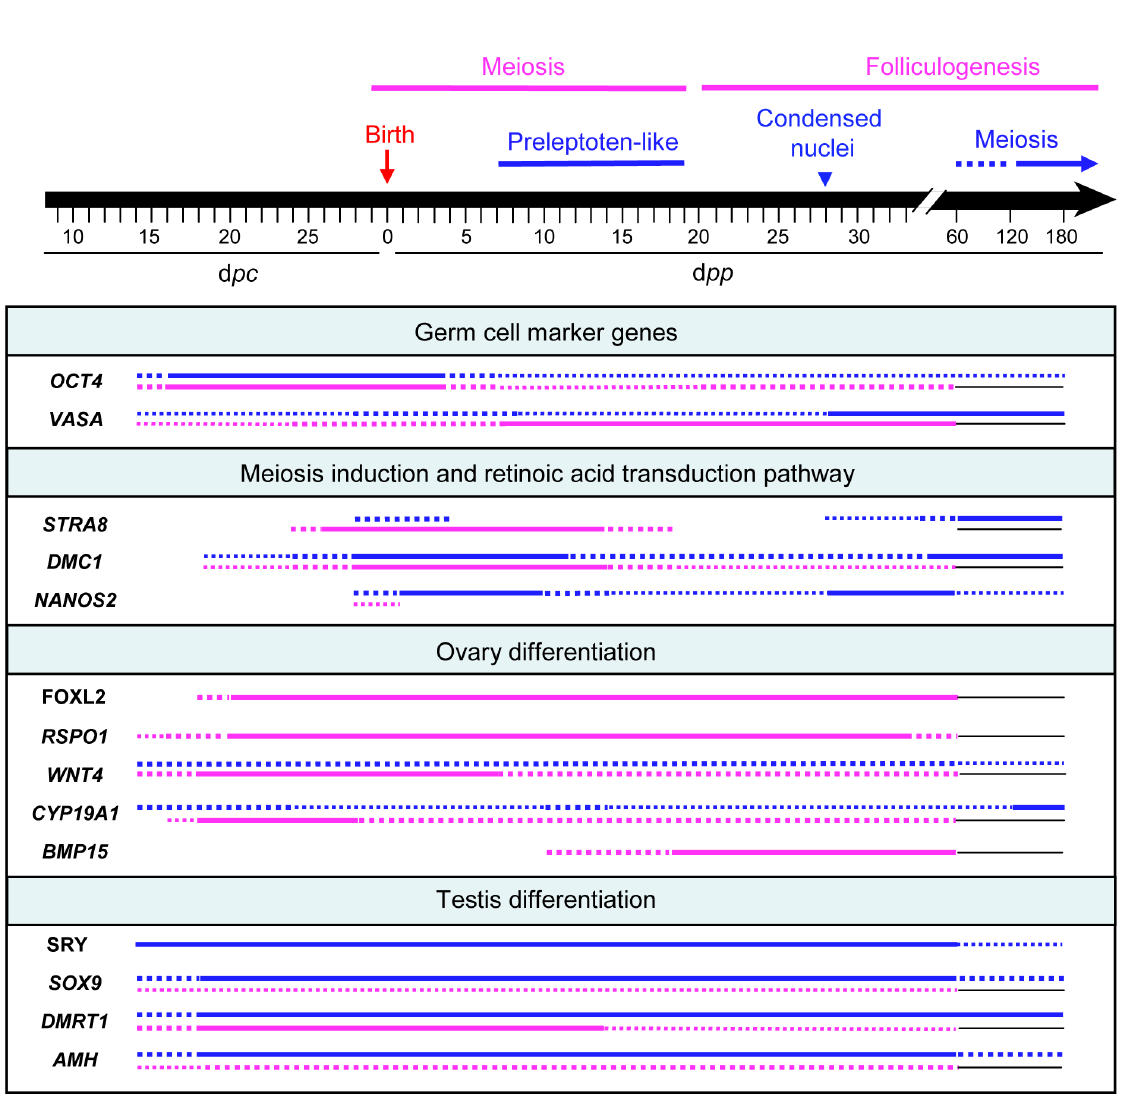
Figure 7. Schematic representation of gene expression patterns and main histological observations. Continuous lines represent a significant gene expression in ovaries (pink) or testes (blue) extracts. Dotted lines indicate that expression is significant but at a lower level. Thin black lines are drawn when no samples were assayed.